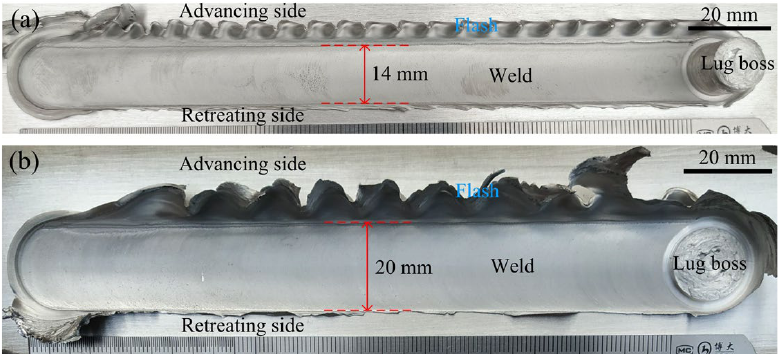
Figure 4. Effect of the stir bar diameter on the weld morphology: ( a ) d = 12 mm; ( b ) d = 16 mm; ( ω = 600 rpm, v = 30 mm/min).